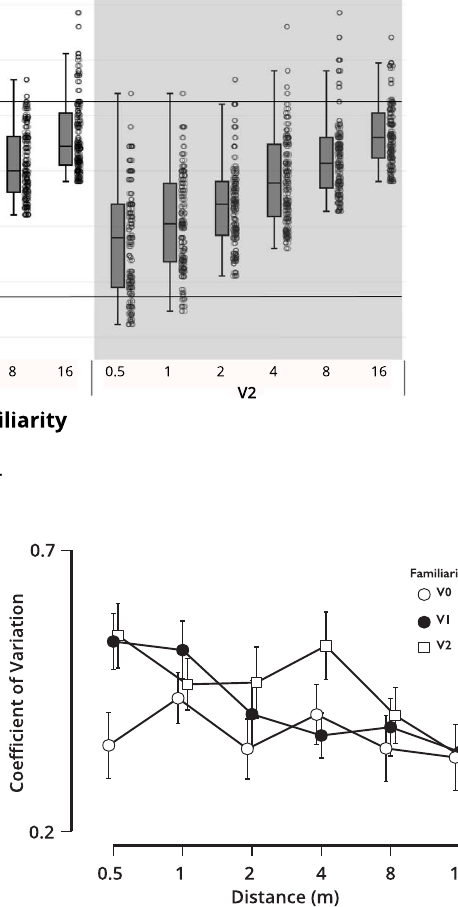
Figure 5. Coef fi cient of variation (CV) for different sentences and different familiarity levels. Mean values and standard error are